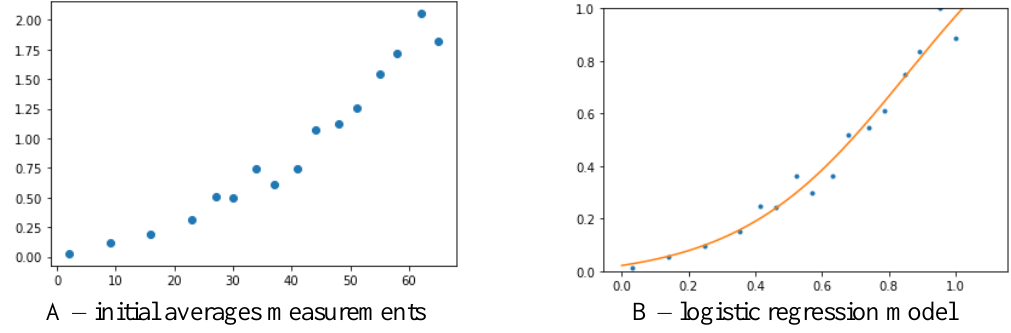
Figure 5. Broiler growth modeled using different models in barn